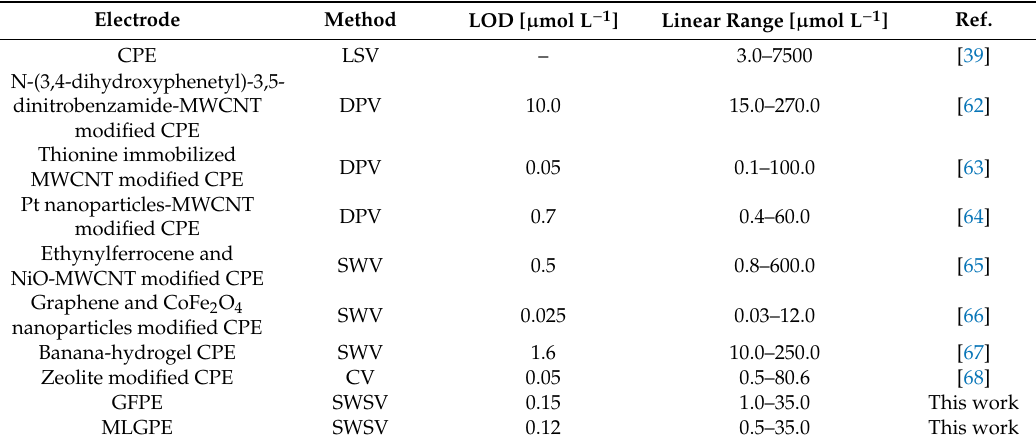
Table 2. Experimental results for various CPEs used for AC determination.